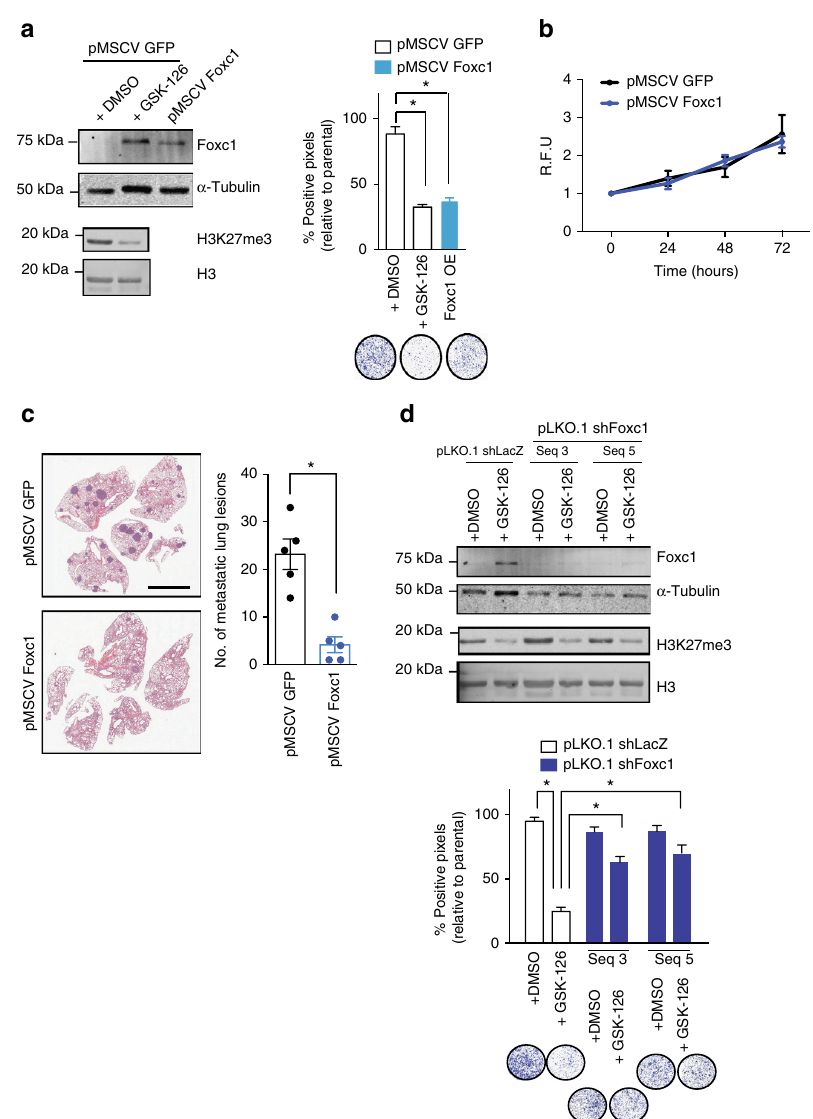
Fig. 5 Ectopic expression of Foxc1 alters invasion but not proliferation. a Transwell invasion assay of PyVmT cells expressing exogenous Foxc1 or GFP. Experiments were performed three times, and results are displayed relative to untreated parental cell. * p < 0.05, Student ’ s two tailed t -tests. b CyQUANT assay measuring cellular proliferation of PyVmT cells expressing exogenous GFP or Foxc1. R.F.U relative fl uorescence units. Data were normalized to the fl uorescence values at time = 0. c Enumeration of lung lesions following the injection of PyVmT cells expressing exogenous Foxc1 or GFP in the tail vein of athymic nude mice. * p < 0.05, Student ’ s two tailed t -tests. Scale bar is 5 mm. d Left: Representative immunoblot showing Foxc1 expression in cells stably transduced with a control shRNA (shLacZ) or two independent shRNAs targeting Foxc1 and treated with DMSO or GSK-126 (2 μ M for 72 h). α -Tubulin was used as a loading control. Right: Transwell invasion assay of PyVmT cells infected with shRNA targeting LacZ (control) or two different sequences targeting Foxc1. Cells were pre-treated with DMSO or GSK-126 (2 μ M) for 72 h and assayed for their capacity to invade through Matrigel. All assays were performed in triplicate. * p < 0.05, Student ’ s two tailed t